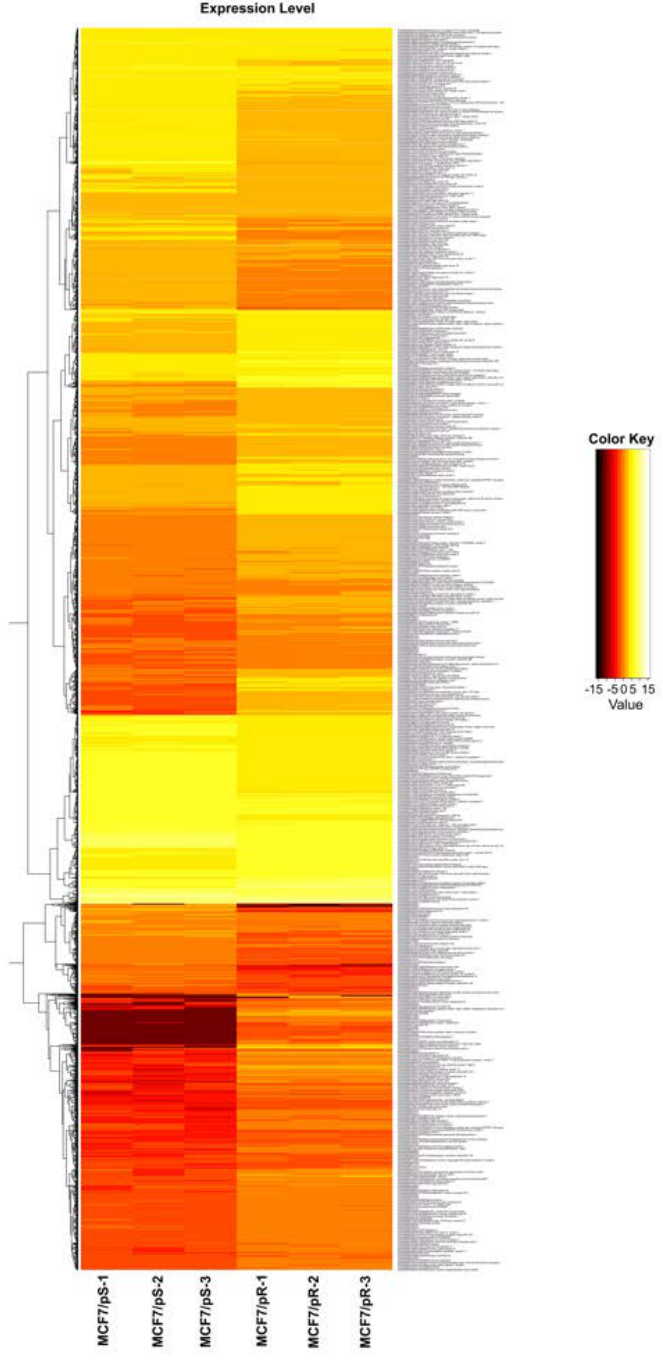
Figure 1. Differential expression heatmap of estrogen receptor-positive (ER+) MCF7 palbociclib-sensitive (MCF7/pS) compared to MCF7 palbociclib-resistant (MCF7/pR) cells. Next-generation transcriptomic RNA sequencing (RNA-seq) was performed and the raw expression of genes is shown as a heatmap. Replicate samples are clustered. Red and yellow indicate lower and higher gene expression, respectively.